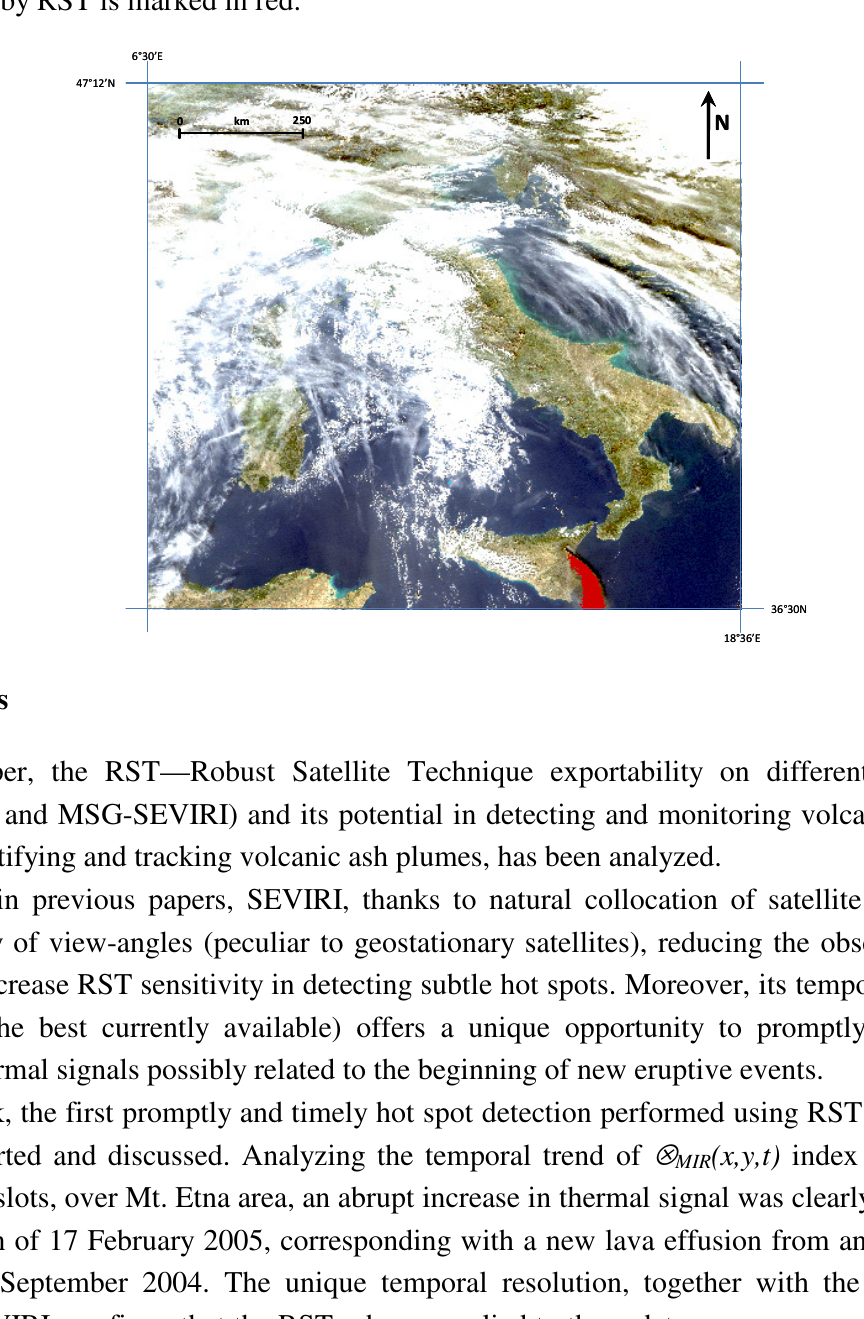
Figure 5. EOS-MODIS RGB image of 30 October 2002 at 12:05 GMT. The ash plume detected by RST is marked in